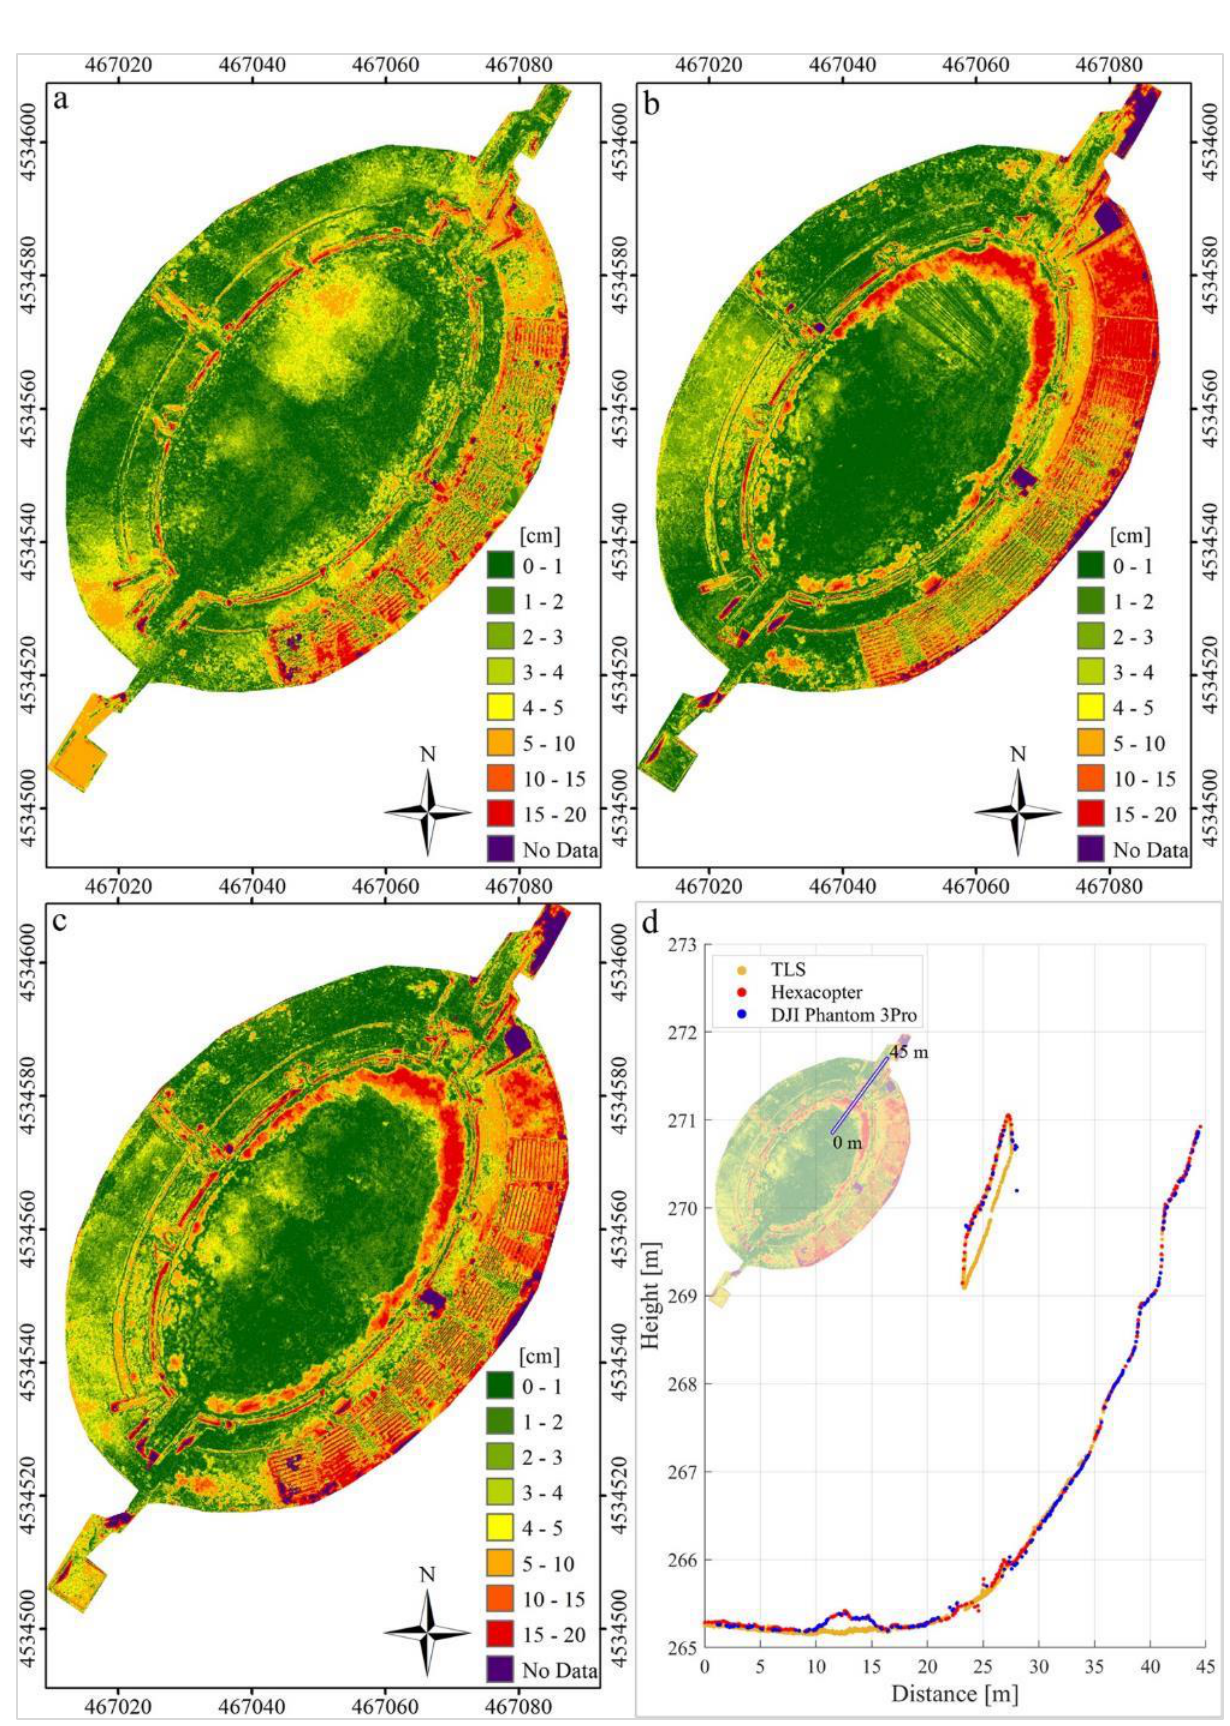
Figure 6. Comparisons between 3D models derived from photogrammetric and TLS surveys. Panel a: Phantom vs Hexacopter; panel b: Hexacopter vs TLS; panel c: Phantom vs TLS. Panel d: